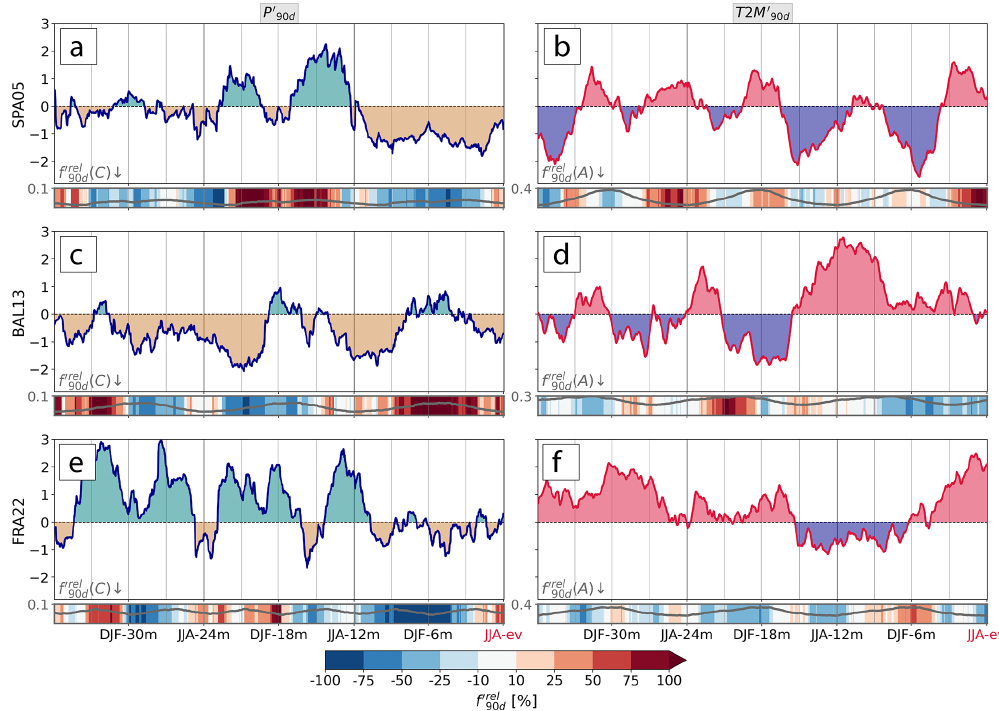
Figure 4. The 3-year evolution of (a, c, e) P (cid:48) and (b, d, f) T 2 m (cid:48) leading up to low-NDVI events in (a, b) Spain in 2005, (c, d) the 90d 90d Balkans in 2013, and (e, f) France in 2022. The relative anomaly of (a, c, e) cyclone frequency and of (b, d, f) anticyclone frequency is shaded, and their climatological mean is shown as a grey line in the heatmap